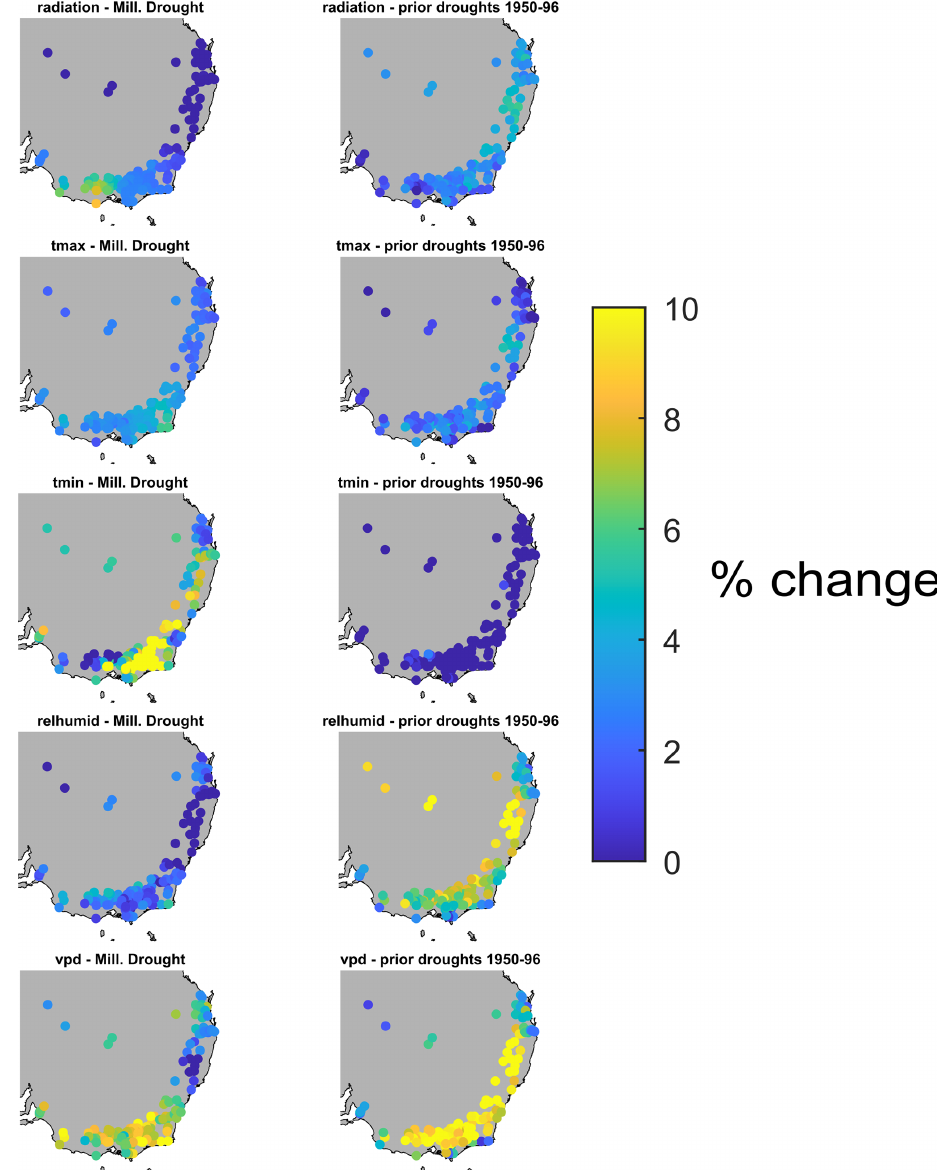
Figure C2. Repeat of Fig. C1 but showing changes in percentage terms rather than actual values.